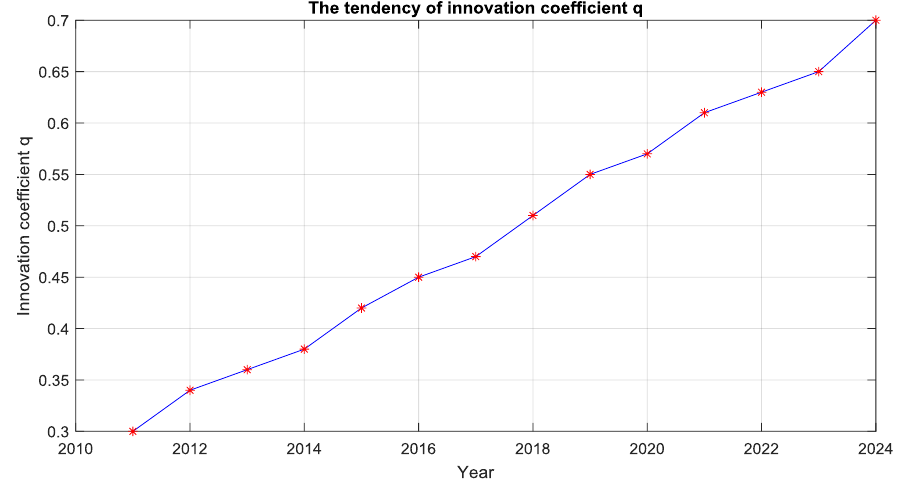
Figure 5. Coefficient of imitation ( q ).